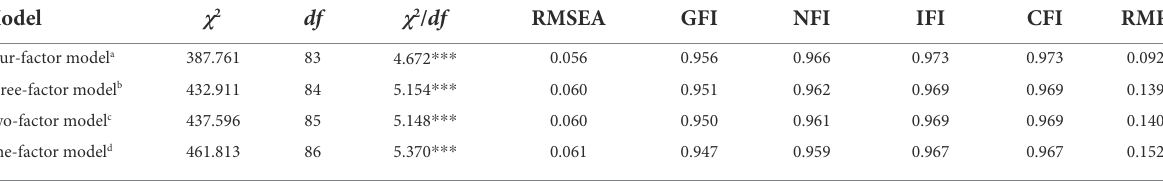
TABLE 4 Confirmatory factor analysis (CFA)